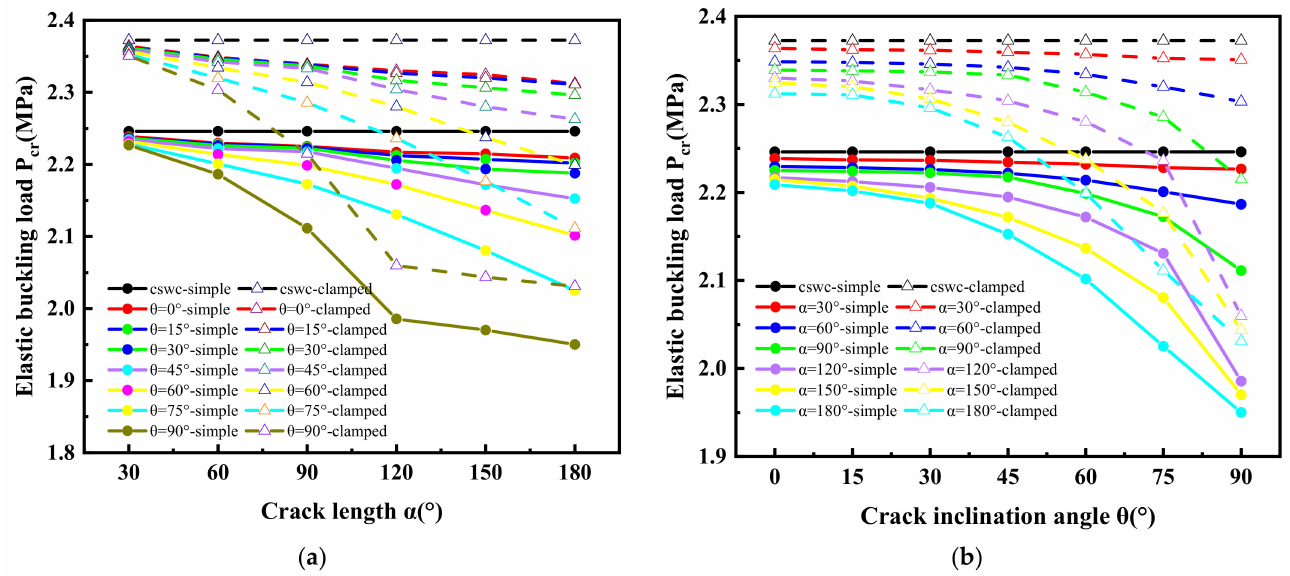
Figure 9. Relation between crack length and elastic buckling load with clamped support at both ends of cylinder ( a ) Different crack lengths; ( b ) Different crack inclination